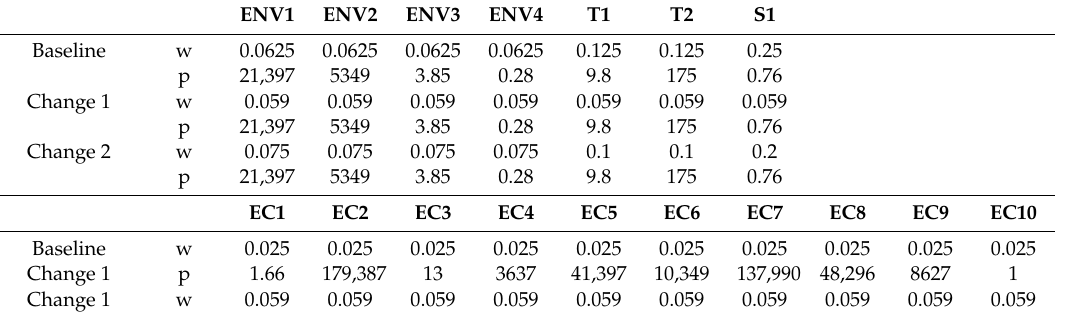
Table 14. Sensitivity analysis. w: weight; p: preference.